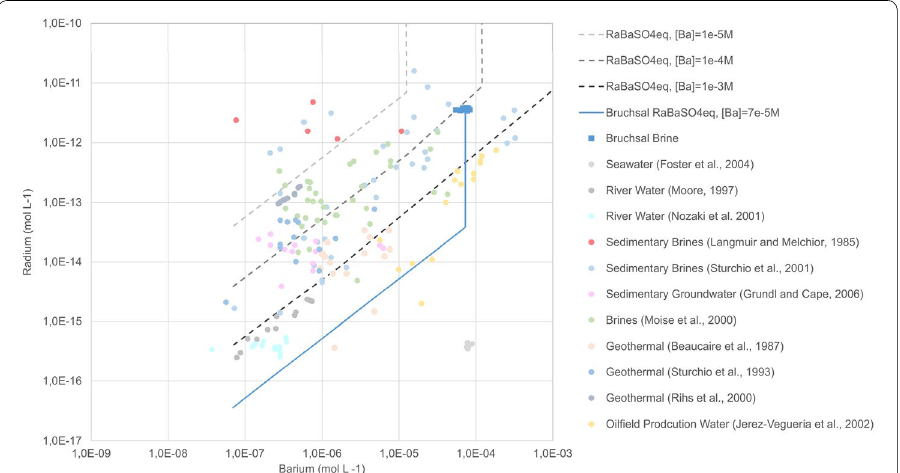
Fig. 8 Re-calculation of radium co-precipitation with barite from literature data (Grandia et al. 2008). Calculations result in (Ra,Ba)SO 4 equilibrium lines having a similar slope for varying natural Ra–Ba